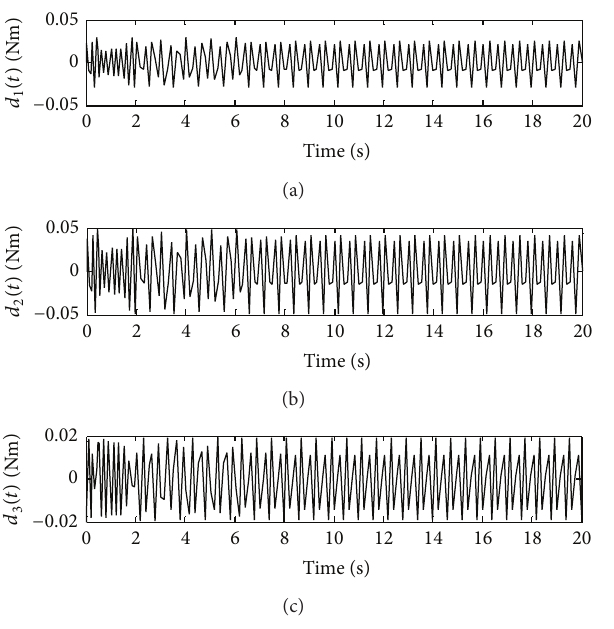
Figure 5: External disturbance; 𝑑(𝑡) = [𝑑 1 (𝑡) 𝑑 2 (𝑡) 𝑑 3 (𝑡)]